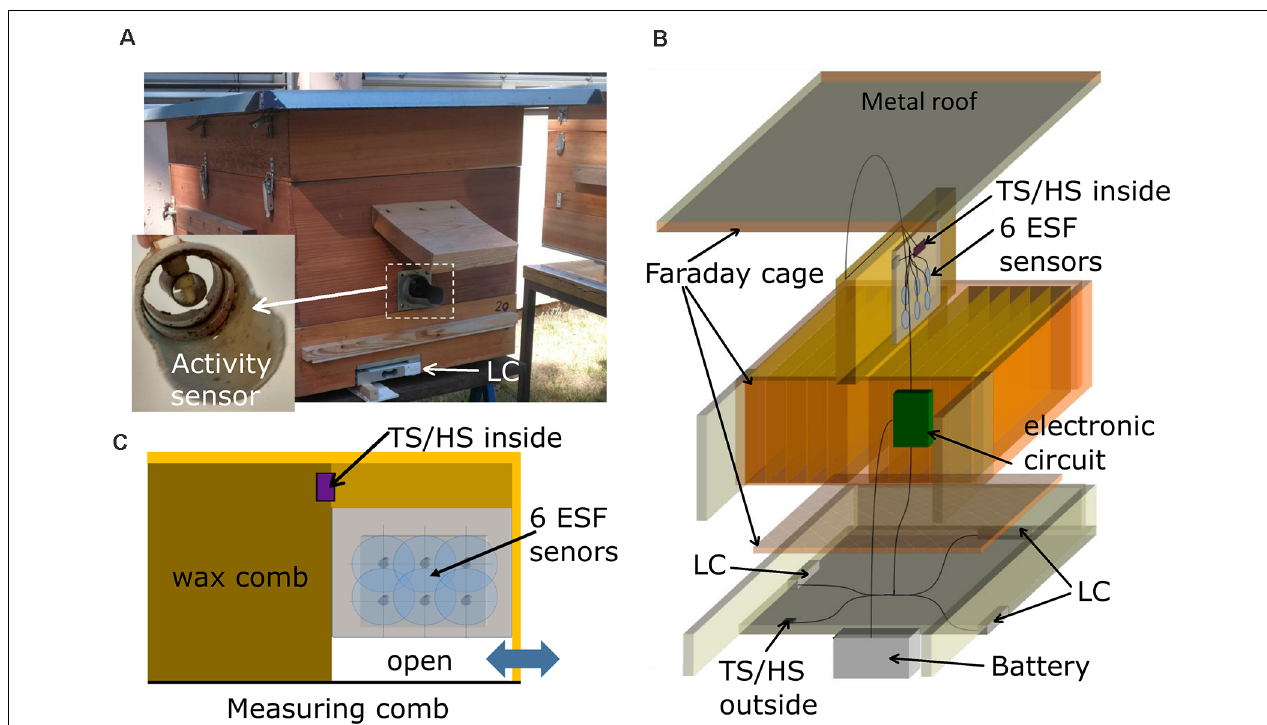
FIGURE 1 | Hive construction and measuring devices. (A) Front and side view of the hive. A plastic tube containing a GPS receiver was fixed to a sidewall (not shown). The weight of the hive was measured with three load cells (LC). The round entrance tube was equipped with a capacity sensor of the bee traffic (insert to A ). A sensor for external temperature and humidity was located below the extension of the hive box (arrow TS/HS outside). (B) The hive was built as a Faraday cage with a metal mesh between two tightly attached wooden plates, a metal mesh as the ground floor and a metal plate as the roof. The middle comb close to the entrance [blue double pointing arrow in (C) ] contained the six ESF sensors. (C) Side view of the measuring comb with the six electrostatic field (ESF)